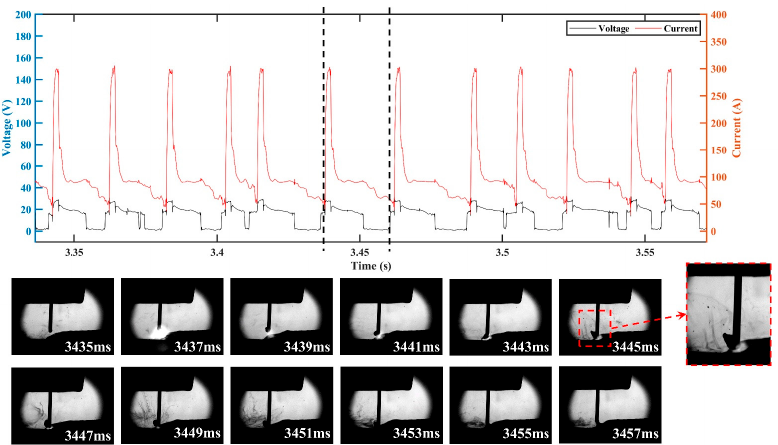
Figure 9. Electrical waveforms and droplet transfer process at I_sc_wait = 90 A.